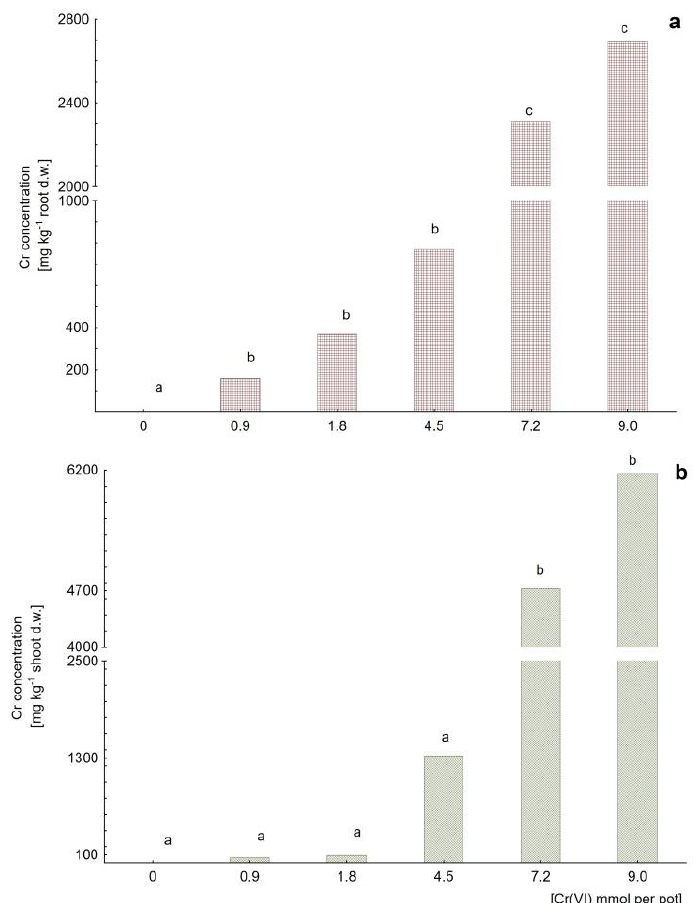
Figure 4. Chromium content in ( a ) roots and ( b ) shoots of Mesembryanthemum crystallinum plants subjected to Cr(VI) applied as potassium chromate, K 2 CrO 4 , at the doses of 0.5, 0.9, 2.3, 3.6 and 4.5 mmol per pot (untreated control at a dose 0). Different letters above the bars indicate statistically significant differences at p ≤ 0.05.